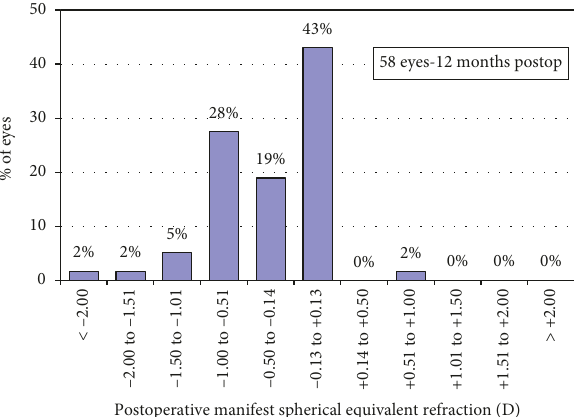
Figure 5: Distribution of manifest spherical equivalent for the patients